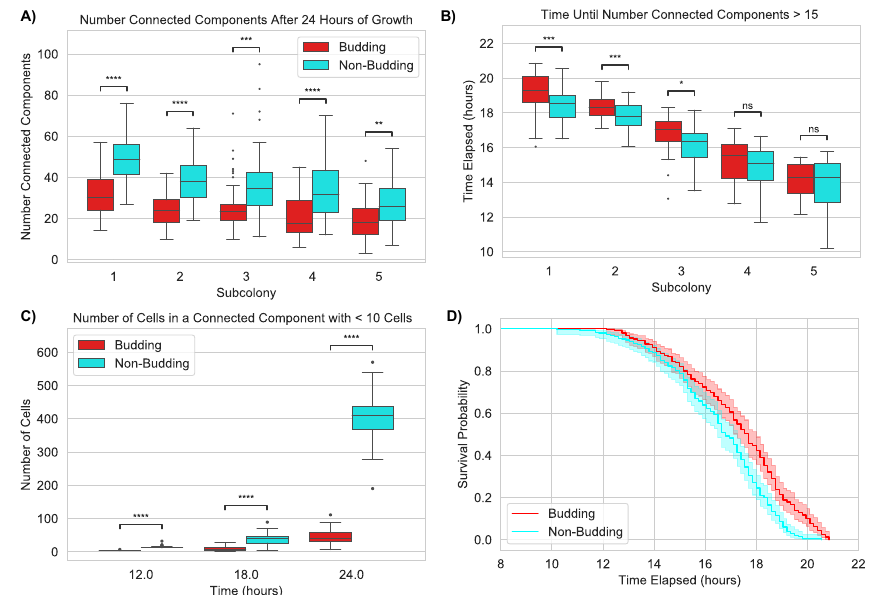
Figure 6. Subcolony Structure and Organization in Nutrient-Rich Colonies. ( A ) Comparison of the number of connected components for the first five subcolonies between budding (red) and non-budding (blue) colonies at the 24 h time point. We observe a statistically significant difference in the number of connected components for subcolony 1 ( p = 2.885 × 10 − 10 ), subcolony 2 ( p = 1.139 × 10 − 10 ), subcolony 3 ( p = 3.075 × 10 − 04 ), subcolony 4 ( p = 1.539 × 10 − 06 ) and subcolony 5 ( p = 1.959 × 10 − 03 ). ( B ) Comparison of time from creation until each of the first five subcolonies splits into 15 connected components. We observe a statistically significant difference between budding (red) and non-budding (blue) colonies for subcolony 1 ( p = 1.140 × 10 − 04 ), subcolony 2 ( p = 4.727 × 10 − 04 ), and subcolony 3 ( p = 1.581 × 10 − 02 ). ( C ) Comparison of the number of cells in a connected component with less than 10 cells. Note that overall very few cells are in small connected components; however, we observe a statistically significant difference between budding (red) and non-budding (blue) colonies at 12 h ( p = 7.408 × 10 − 40 ), 18 h ( p = 7.896 × 10 − 19 ) and 24 h ( p = 1.233 × 10 − 59 ). ( p -values in ( A – C ) were computed using independent t -tests. p -value annotation is as follows. *: 1.0 × 10 − 2 p ≤ 5.0 × 10 − 2 , **: 1.0 × 10 − 3 p ≤ 1.0 × 10 − 2 , ***: 1.0 × 10 − 4 p ≤ 1.0 × 10 − 3 , ****: p ≤ 1.0 × 10 − 4 .). ( D ) Kaplan-Meier survival curves for the length of time a subcolony is made up of less than 15 connected components for budding (red) and non-budding (blue) colonies. The y -axis is the probability that a subcolony consists of less than 15 connected components for longer than t hours, where time is on the x -axis. We observe that the survival curves are different between the budding and non-budding colonies ( p = 1.165 × 10 − 06 ), indicating that budding promotes subcolony connectivity. (The p -value comparing survival curves was calculated using a log-rank test as described in Section 4.3. In addition, 95% confidence intervals for the survival function are shown. See Section 2.1.4 for